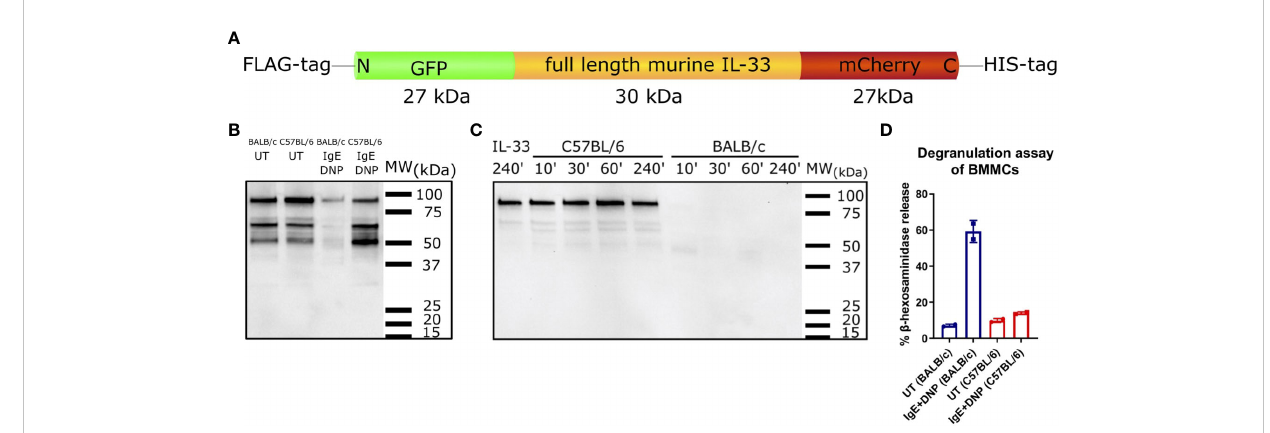
FIGURE 5 IL-33 degrading abilities of supernatants from C57BL/6 and BALB/c BMMCs. Schematic representation of the GFP-murine IL-33-mCherry fusion protein used for IL-33 cleavage assay with BMMCs supernatants (A) . Supernatants from C57BL/6 or BALB/c BMMCs, which were either stimulated with IgE+DNP or left untreated were incubated with GFP-murine IL-33-mCherry for 1 h (B) . IL-33 degradation was analysed by western blotting. Supernatants from IgE +DNP stimulated C57BL/6 or BALB/c BMMCs were incubated with GFP-murine IL-33-mCherry for 10, 30, 60, or 240 min at 37°C. IL-33 incubated only in buffer for 240 min at 37°C served as negative control. IL-33 degradation was analysed by western blotting (C) . Beta-hexosaminidase degranulation assay of untreated or IgE+DNP stimulated BMMCs from C57BL/6J or BALB/c mice (D) . Data are presented as mean ±